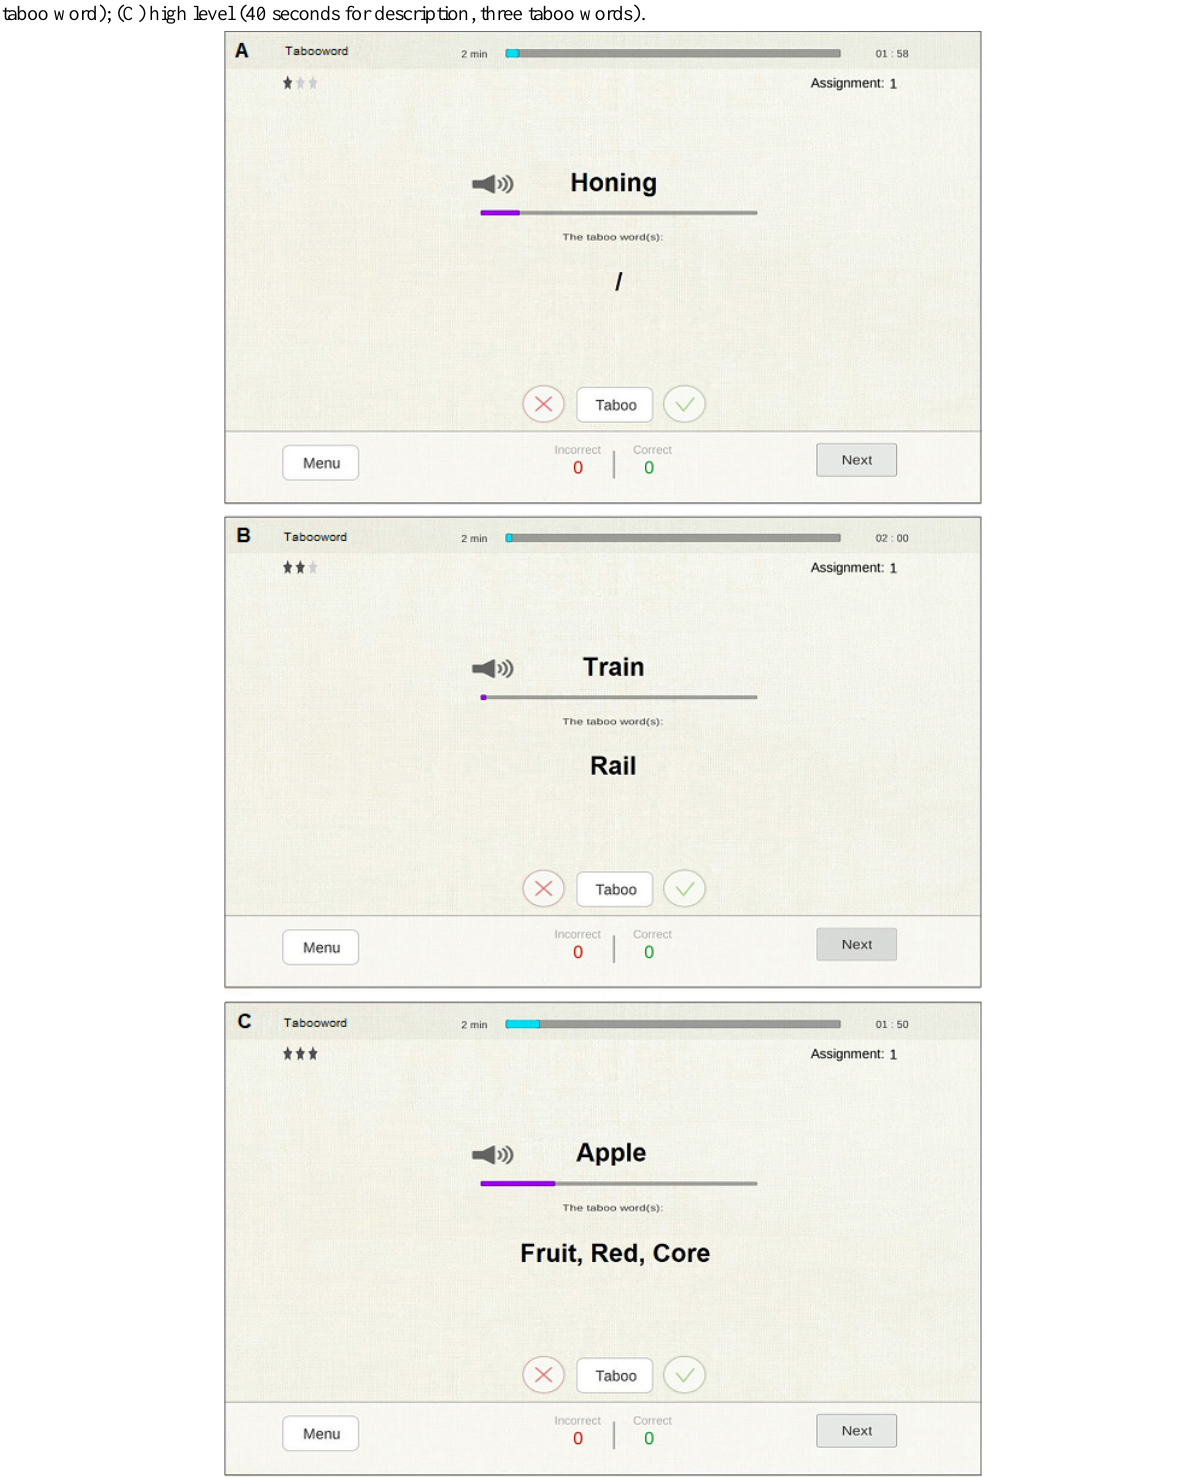
The therapist judges the clarity of the description by pressing score buttons as follows: green for a good description within the time limit and red for a bad description. The “Tabooword” button has to be pressed when the patient breaks one of the five rules (eg, uses the word apple to describe an apple tree). The “Tabooword” button can be used three times before the full assignment is scored as wrong; thus, each time the “Tabooword” button is used, the patient receives minus one-third of the score.